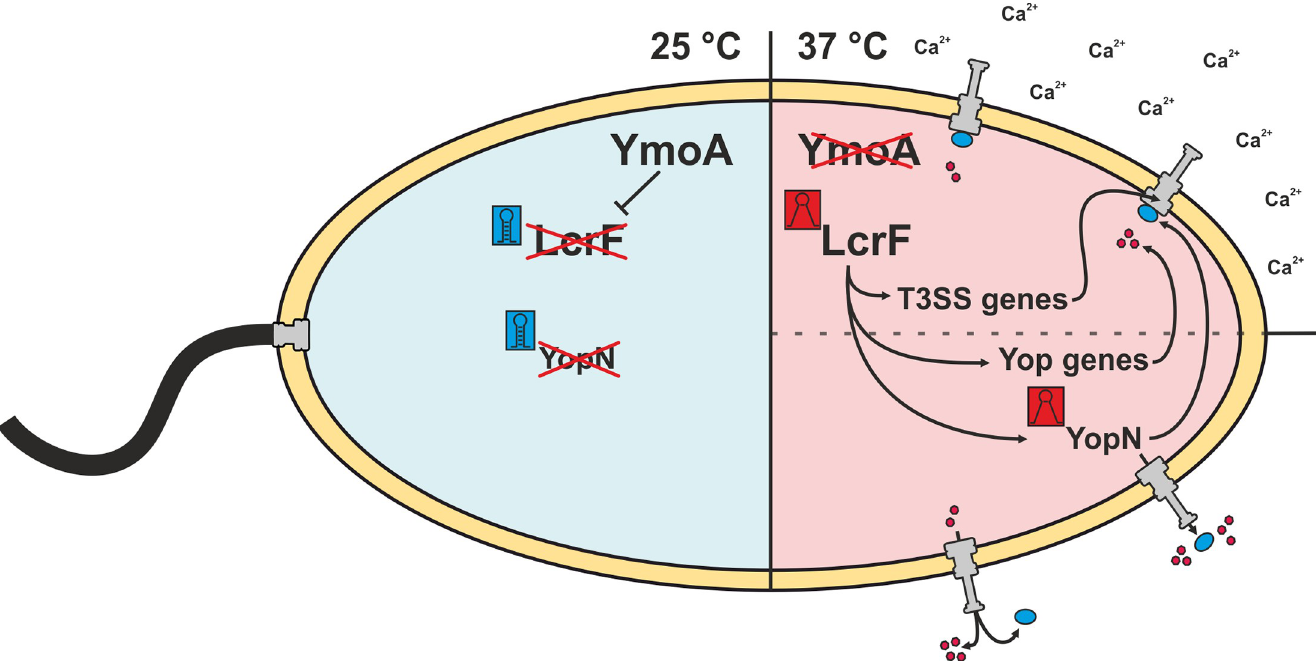
Fig 9. Overview of temperature-dependent regulatory pathways regarding the assembly and functionality of the T3SS. At ambient temperatures (25˚C), Yersinia downregulates virulence-associated pathways while the flagellar synthesis is induced [56]. The global regulator YmoA represses the expression of the main virulence regulator lcrF at 25˚C [53,57–59].Besides, RNA thermometers (RNATs) also contribute to repression of specific genes like lcrF itself or the secretion regulator yopN [34]. At virulence-relevant temperatures (37˚C), YmoA is degraded by proteases which leads to the derepression of lcrF [59]. Furthermore, melting of the lcrF RNAT increases the expression induction and synthesis of the virulence regulator and thus induce the expression of T3SS genes and effector protein genes (Yop genes) [34]. The transcript of yopN posseses an RNAT that additionally induces its expression at 37˚C. In calcium-containing environments, YopN together with TyeA and the chaperone complex SycN/YscB prevents the secretion of Yops by blocking the T3SS channel in the cytosol. In contrast, the complex dissociates under calcium deficiency allowing first the secretion of YopN and subsequently the secretion of further Yops into the surrounding medium [20,22,23,26,27]. Blue box: closed RNAT; red box: open RNAT; red circles: Yops; blue circles: